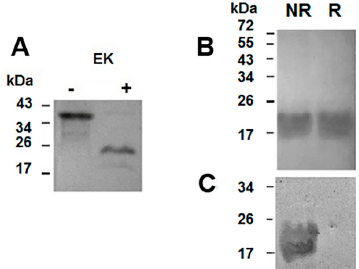
Figure 3. Trx-rHelja digestion with enterokinase and rHelja purification. Aliquots of the mix containing enterokinase after (+) and before ( − ) of the incubation were loaded on 12% SDS-PAGE and subsequently transferred to nitrocellulose, blocked and incubated sequentially with 1:3000 anti Helja polyclonal antibodies and 1:10,000 alkaline phosphatase-conjugated anti-rabbit IgG ( A ). Aliquots of the proteins from the non-retained (NR) or the retained (R) peaks obtained after loading the products of the enterokinase digestion on the Ni 2+ -Sepharose matrix were analysed in a 12% SDS-PAGE and stained with Coomassie Brillant Blue ( B ) or transferred to nitrocellulose, blocked and incubated sequentially with 1:3000 anti Helja polyclonal antibodies and 1:10,000 alkaline phosphatase-conjugated anti-rabbit IgG ( C ). Figures are representative of three ( n = 3) independent experiments. Molecular mass markers are indicated on the